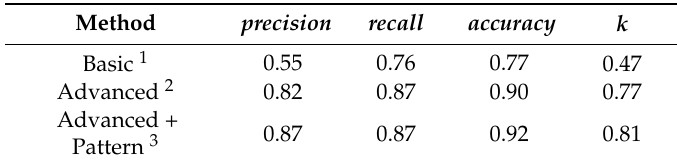
Table 1. The performance of our change detection algorithm in three versions (all values range from 0 to 1 and a higher value indicates a higher level of